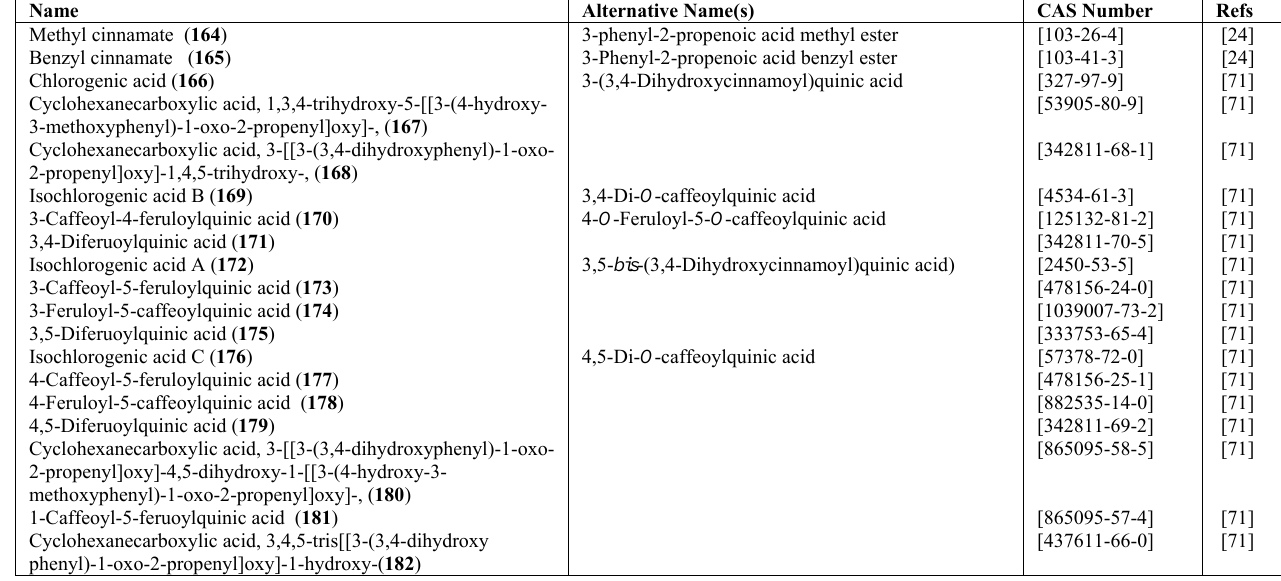
Table 16. Cinnamyl, Caffeoyl and Ferruloyl